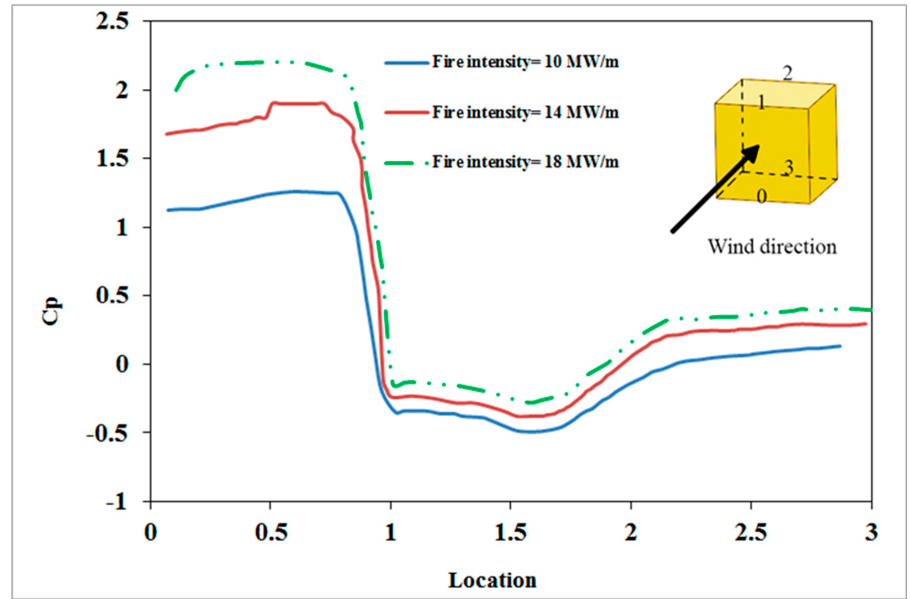
Figure 10. Mean pressure coefficient for fire intensities 10, 14 and 18 MW/m.